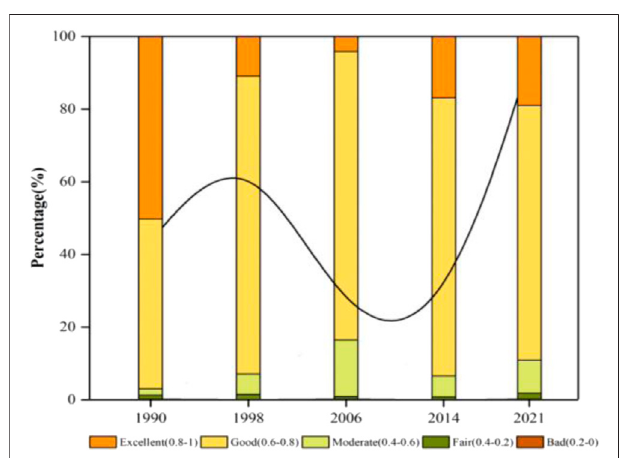
FIGURE6| Areadistributionofecologicalenvironmentalqualitylevelson Jianghan Plain from 1990 to